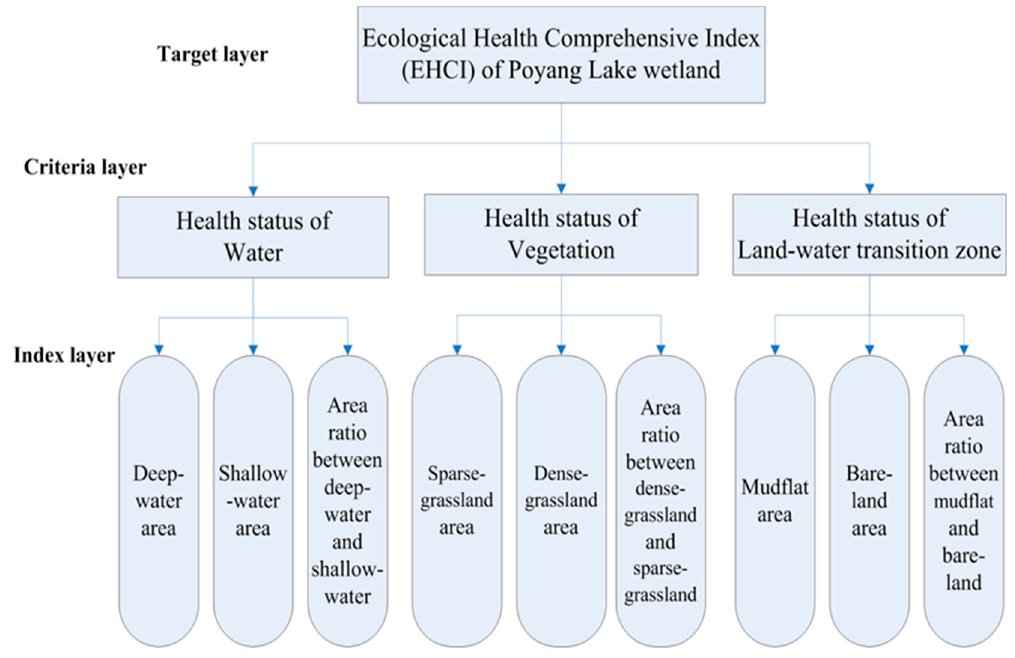
Figure 2. The structure of the ecological health comprehensive index (EHCI) at Poyang Lake wetland. Table 2. Weight of each indicator in the evaluated index